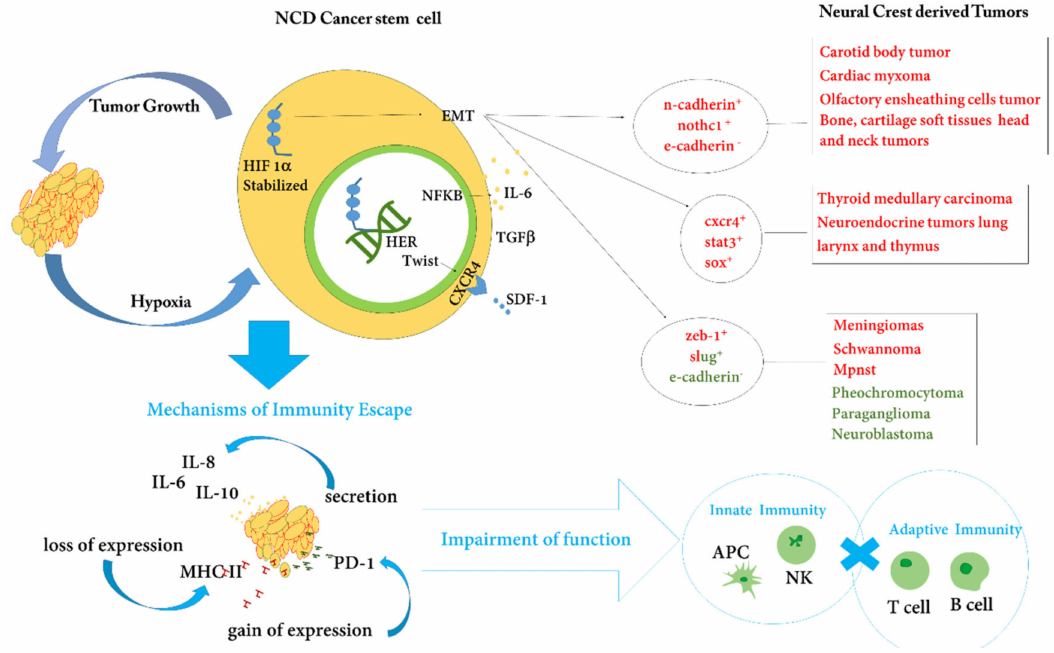
Figure2. Stemcellsoftheneuralcrest-derivedtumors(NCDTs)makeepithelial–mesenchymaltransition (EMT) pathway reactivating together with the immunological suppression strategies useful during the embryonic life to guarantee maternal-fetal and intra-embryonic immune tolerance. The principal antigens connected to EMT in NCDTs are detailed related to the type of tumor. Moreover, NCDTs maintain a distinctive trait related to the common upregulation of the HIF (hypoxia-inducible factor) -dependent pathway. Hypoxia-inducible factor (HIF) and hypoxia response elements (HRE) are used by embryonic stem cells to modulate their own stemness. In the tumor context, HIF triggers EMT in cancer cells, both HIF and EMT favor cytokine release inducing inflammation. These actions are sustained by hypoxia, that during tumor growing increased proportional to the tumor volume, and induces HER HIF-dependent. HIF determine a dependent positive feedback loop that included NF-kB, IL-6, STAT3, favoring further cytokines are released to trigger inflammation and to impair innate immunity reactions. Both TWIST1 and TGF- β 1 are, in turn, regulated by directly or indirectly binding to HER HIF-dependent. TWIST1 is able to repress expression of E-cadherin, to coordinate EMT and chemotaxis toward the chemokine SDF-1 by upregulating its receptor CXCR4. SDF1 / CXCR4 is involved in the chemotactic guidance and its activation is common in the progression phase of NCDTs. Finally, both EMT and HIF pathways in NCDTs are able to induce MHC II loss of expression and gain of expression of PD-1, impairing the adaptive immunity by B and T cells function